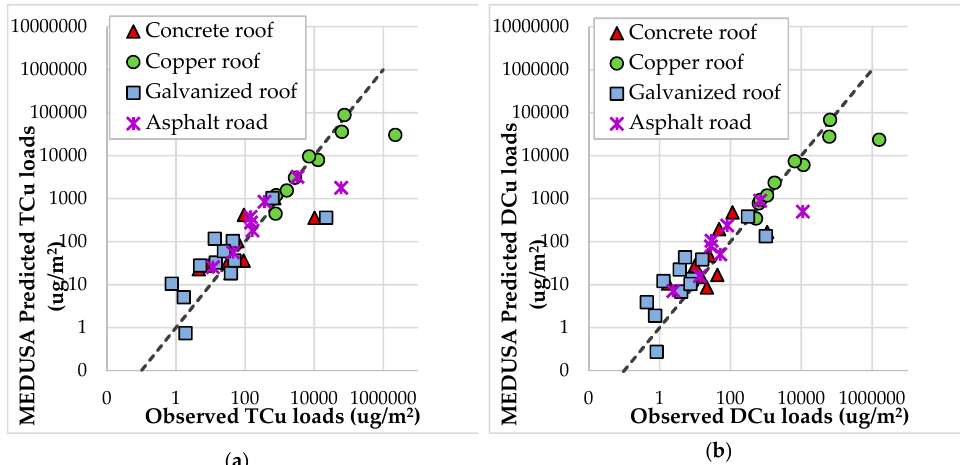
Figure 4. Predicted total suspended solids (TSS) loads against observed loads for Okeover surfaces.